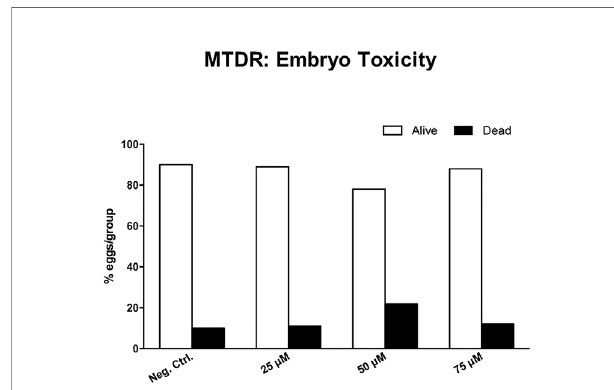
FIGURE 14 | Chick embryo toxicity of MTDR. Note that MTDR was non- toxic, as compared to the vehicle alone control (n ≥ 17), over a dose range of 25, 50, and 75 m M.